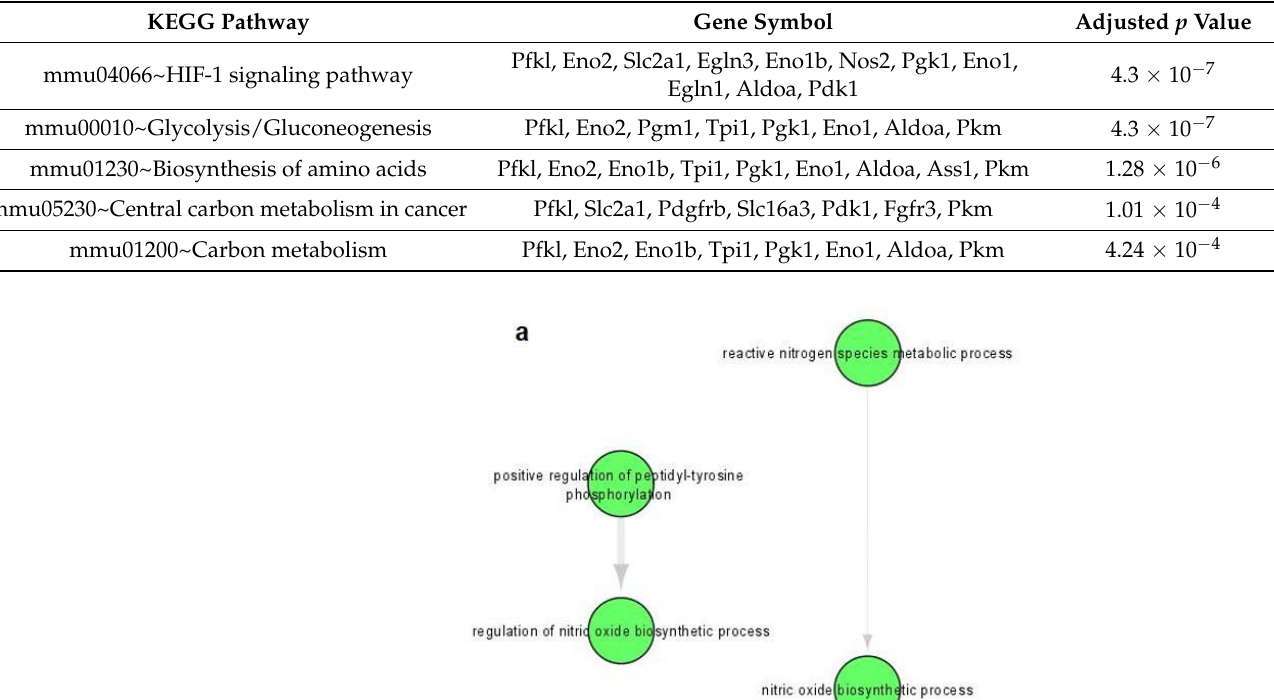
Table 2. KEGG pathways enriched by upregulated DEGs in L. infantum -infected BM-DCs.